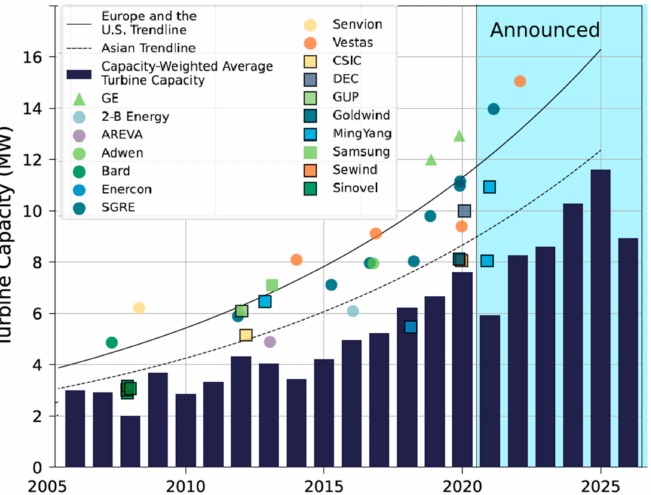
Figure 8. Installed and planned new annual capacities of offshore turbines until 2025